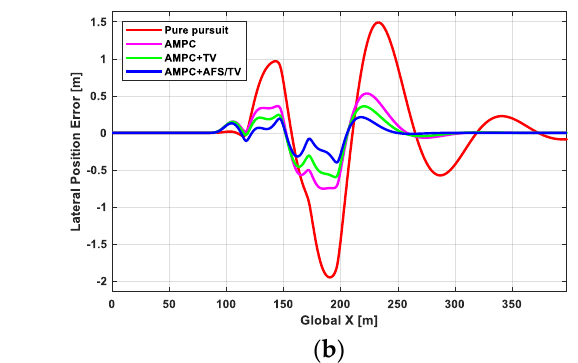
Figure 6. ( a ) Vehicle trajectory and ( b ) lateral position error.